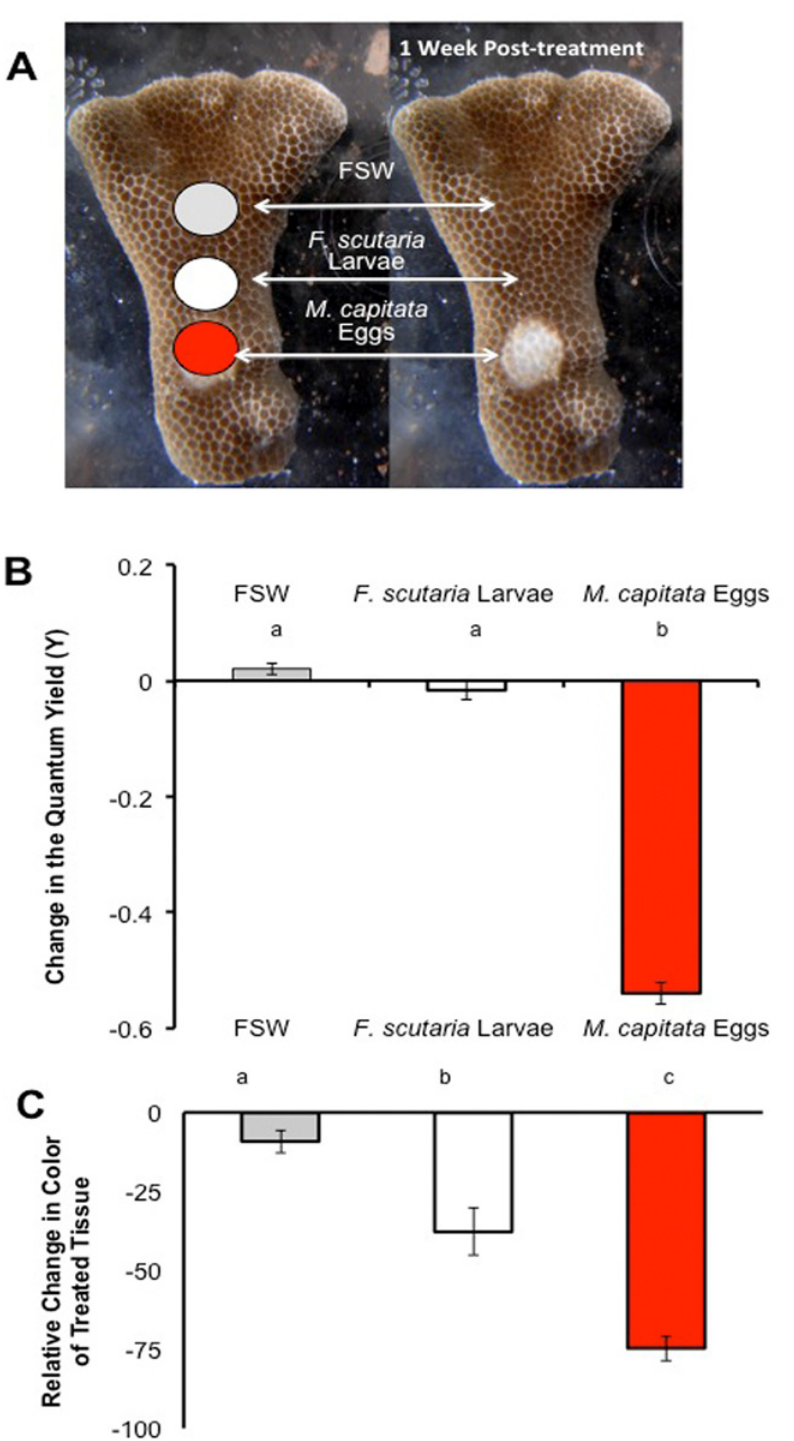
Fig 6. The addition of crushed M . capitata eggs negatively impacted sperm motility and in vitro fertilization success. (A) When 5 µ l of FSW was added to M . capitata sperm , its motility remained constant over time, however when 5 µ l of crushed M . capitata eggs were added to M . capitata sperm, the motility decreased greater than 90% after 15 and 30 min. (B) After 30 min, the uncrushed- and crushed egg-treated sperm were tested in in vitro fertilization assays. The sperm exposed to the crushed eggs showed